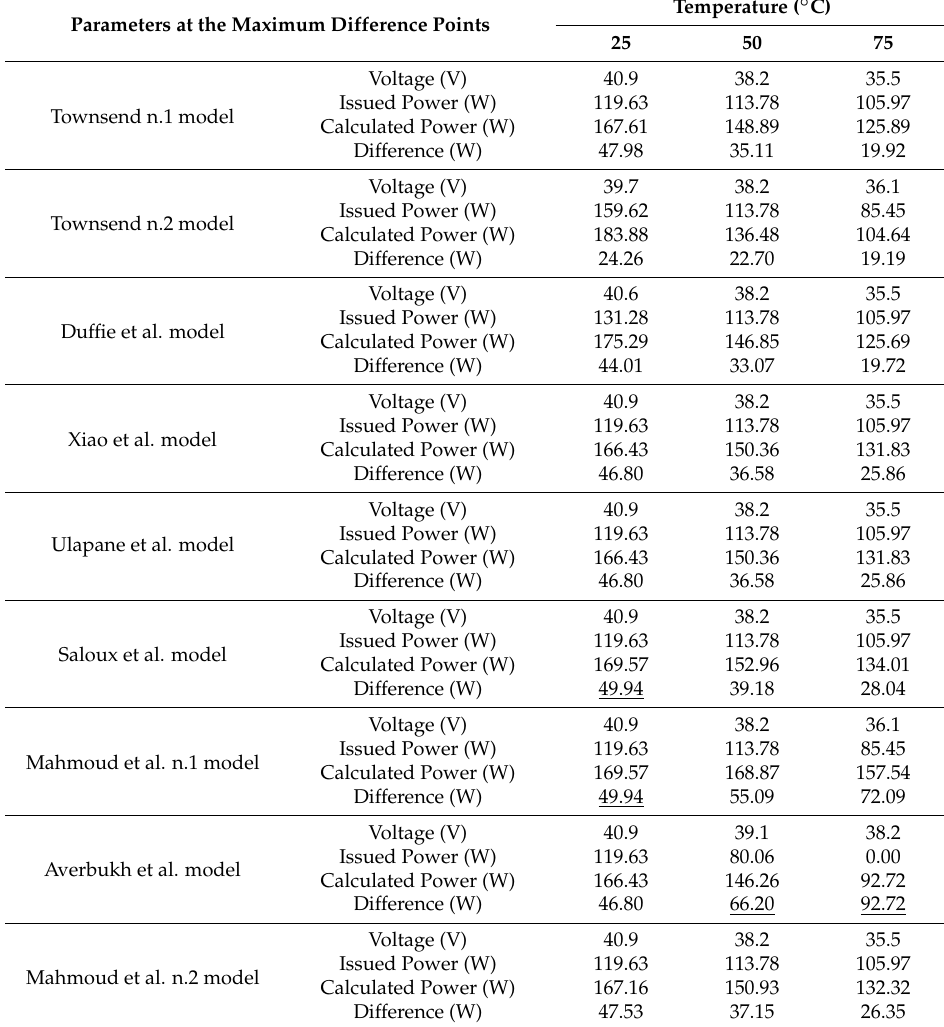
Table 14. Maximum power differences between the calculated and the issued I-V characteristics of Sanyo HIT-240 HDE4, at irradiance G = 1000 W/m 2